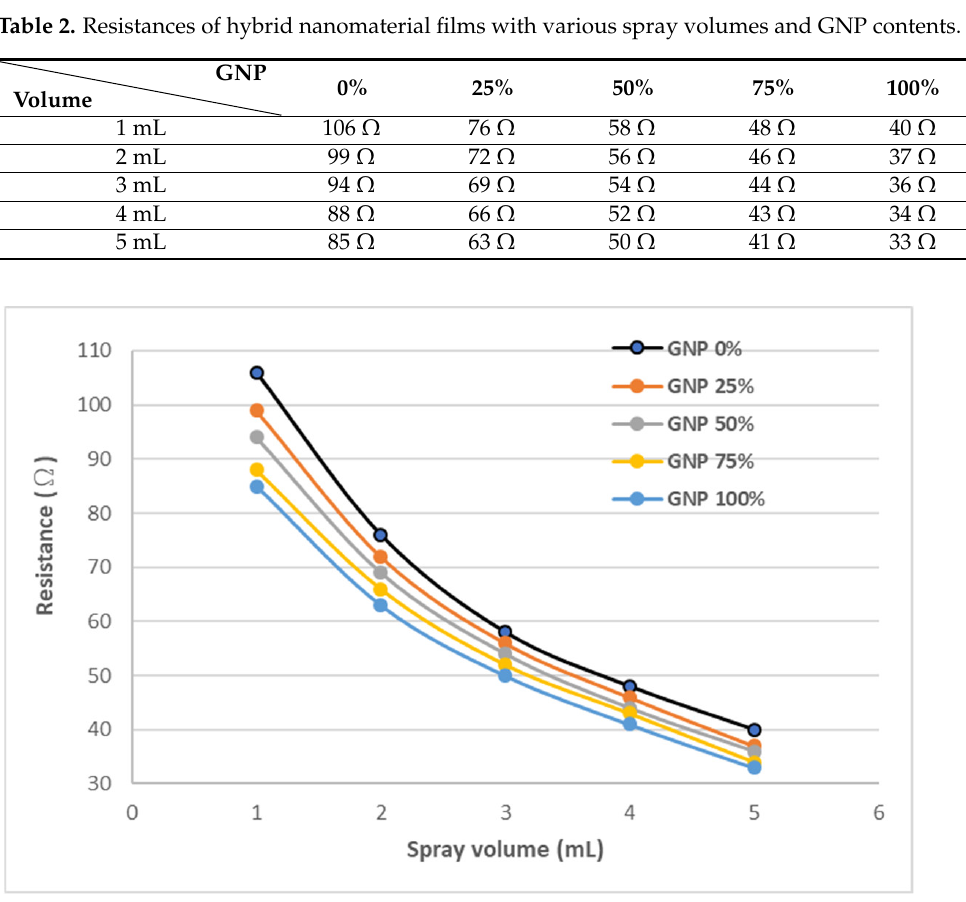
Table 2. Resistances of hybrid nanomaterial films with various spray volumes and GNP contents.